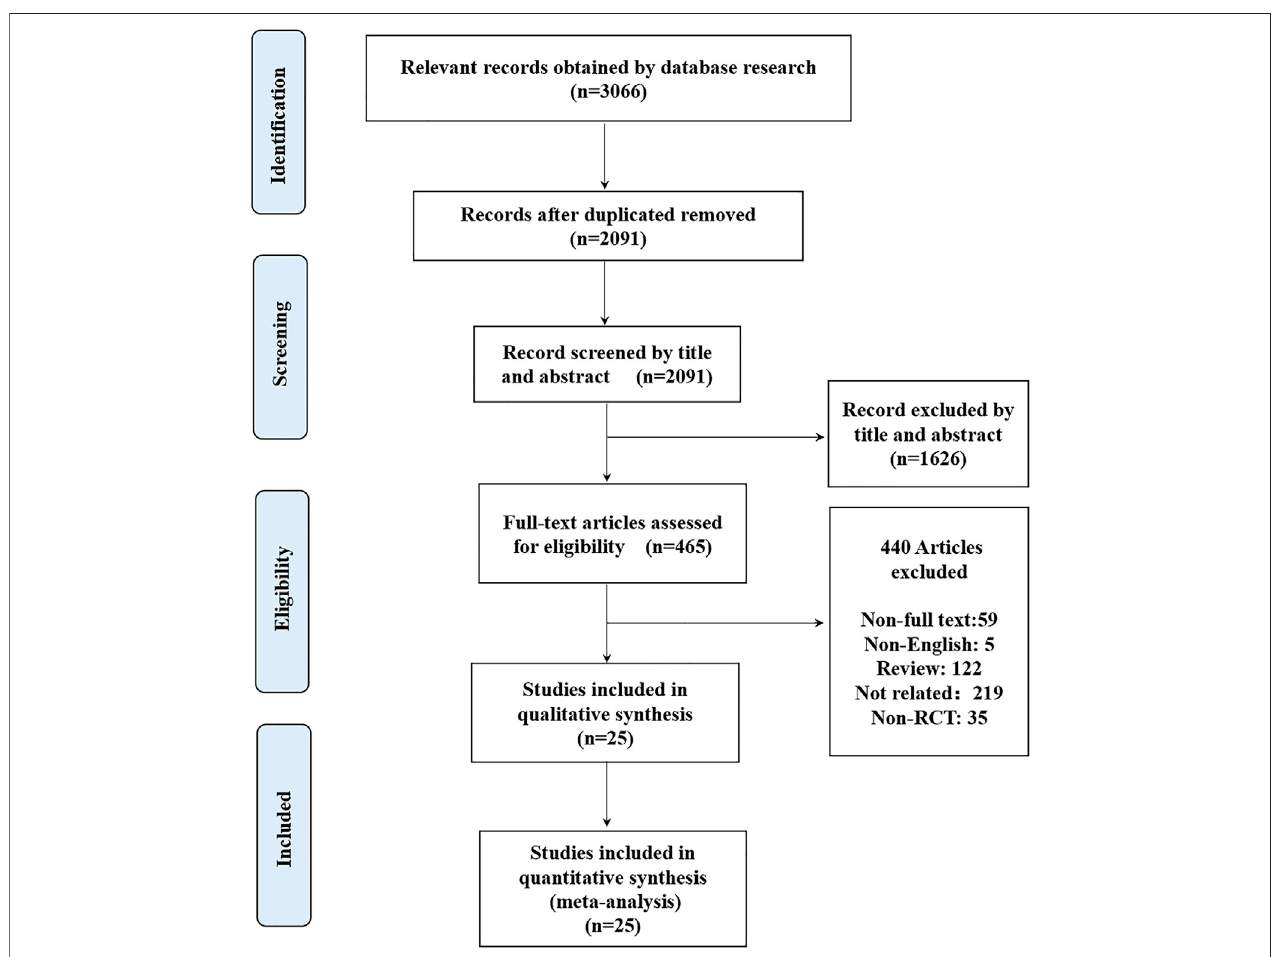
FIGURE 1 | Flow diagram of study